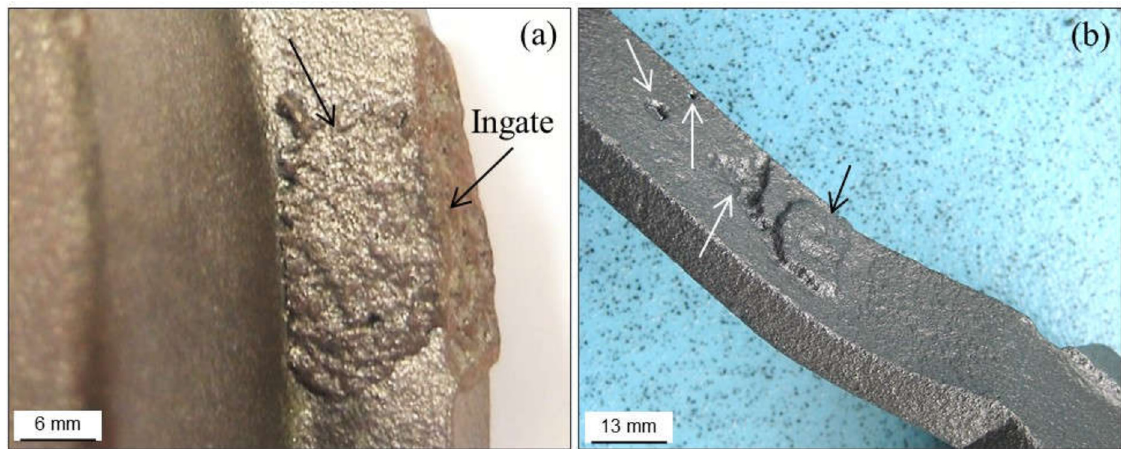
Figure 26. Erosion scabs found in ( a ) an area of a casting close to the ingate and ( b ) one runner of a filling bunch.